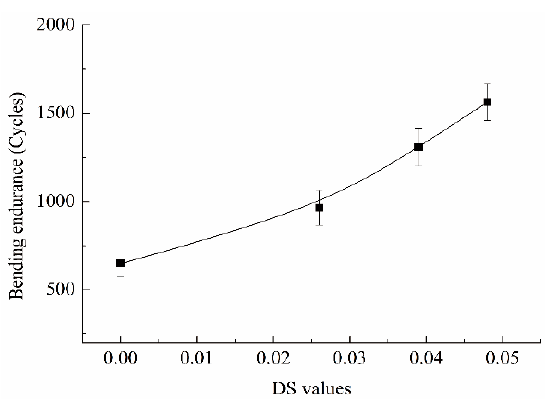
Figure 9. SEM images of the cross sections of OTS film ( a ) and QHOTS film ( b ). Polymers 2018 , 10 , x